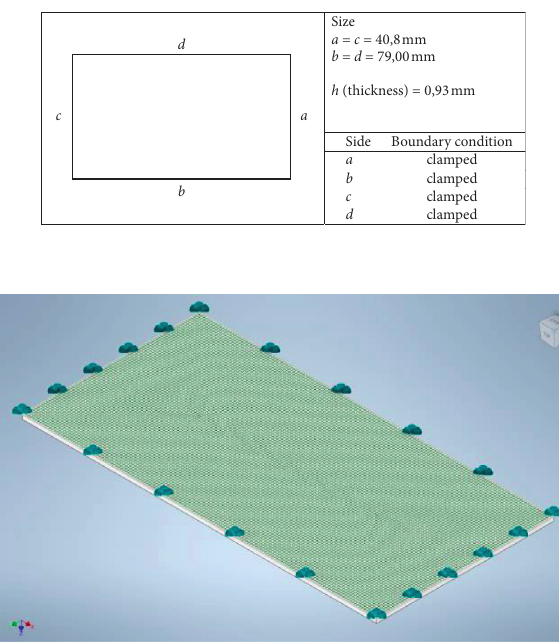
Table 7: Geometrical properties and boundary conditions (Case 2).